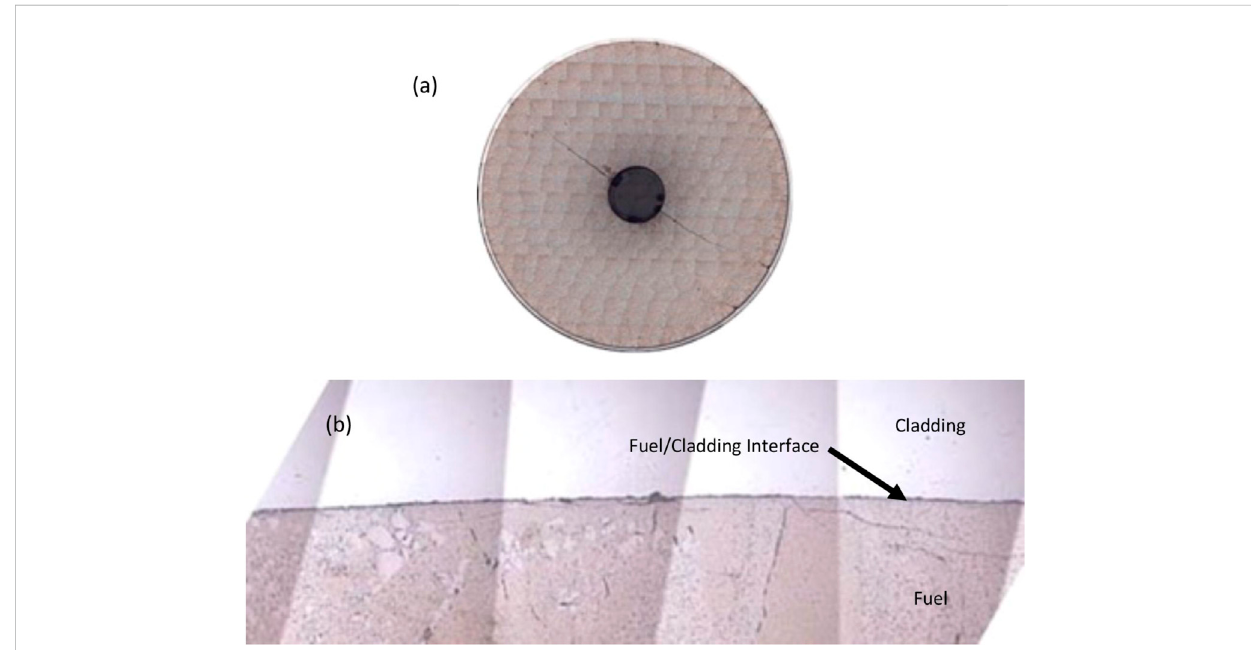
OM image montage (A) at ×31.5 magni fi cation of the as-irradiated TRIGA fuel microstructure, and OM image (B) at ×200 magni fi cation, showing a fuel to cladding region with the best signs of potential fuel and cladding contact.